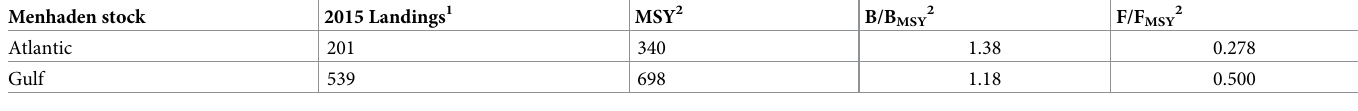
Table 5. Realized landings (10 3 t), MSY (10 3 t), and catch-based indicators of stock status for Atlantic and Gulf menhaden. Menhaden stock